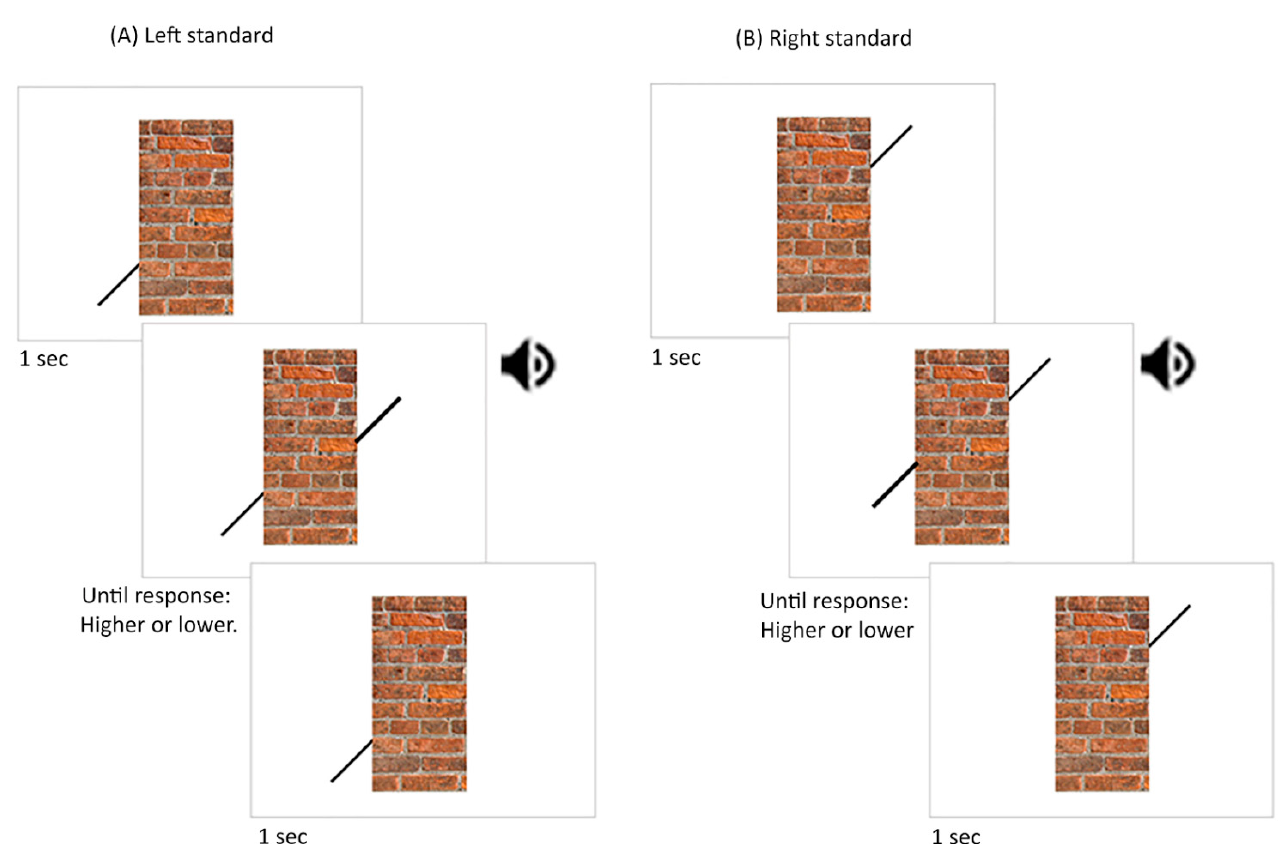
Figure 3. Stimuli and procedures used in experiment 1. For the left standard-line block ( A ), the left standard line was shown for 1 s, followed by an alerting sound cue that signalled the presentation of the right comparison line. For the right standard-line block ( B ), the right standard line was shown for 1 s, followed by an auditory alerting cue that signalled the presentation of the left comparison line. The participant was required to indicate whether the comparison line was higher or lower than the point with which the two lines were colinear. The speaker symbols illustrate when the auditory alerting cues were presented.